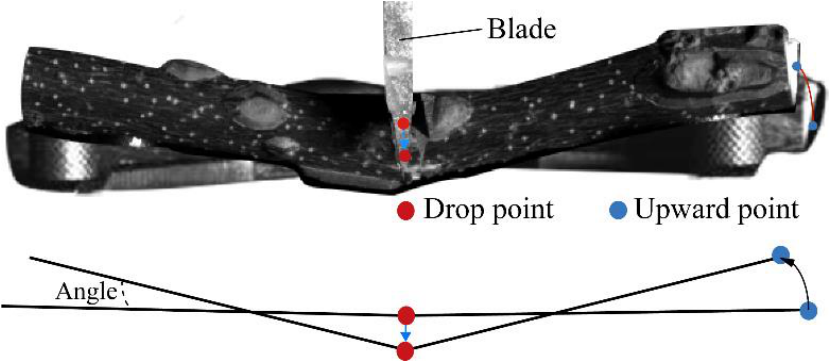
Figure 11. Green pepper branch cutting deformation schematic. The images were extracted under the conditions of an optimal speed of 5.01 mm · s − 1 with a blade angle of 16 ◦ . The images were taken by a high-speed camera and processed using Image-J (National Institutes of Health) software to extract the falling distance of the central compression reference point every 0.05 s. The rising distance and lateral distance of the rising reference point at both ends, the deformation angle of the green pepper branches β , and the related data were processed and plotted as shown in Figure 12.